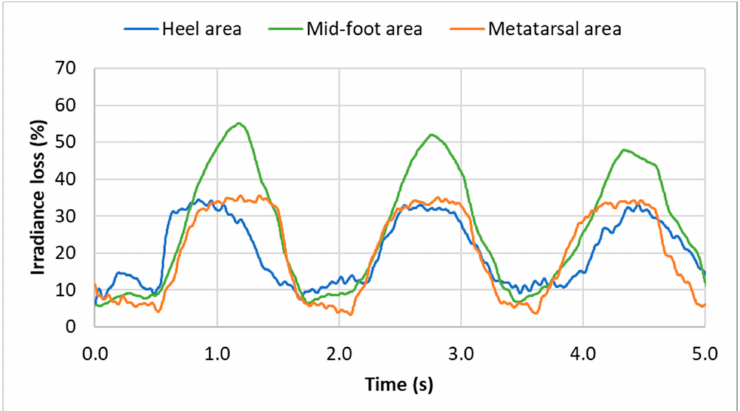
Figure 18. Evolution of the irradiance loss during walking at 2 km / h for three optical fibers placed at three di ff erent positions under the feet, for three walking steps. Each curve is the average of five